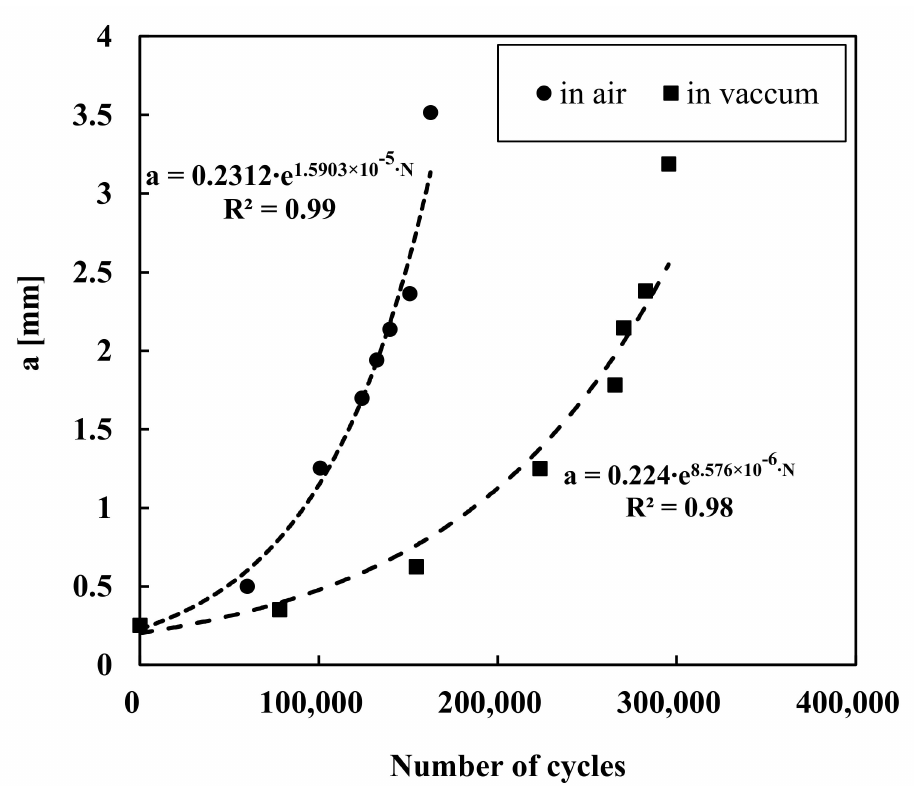
Figure 5. Effect of environment on a-N curves ( σ max = 382 MPa, σ min = 0, Ti6Al4V